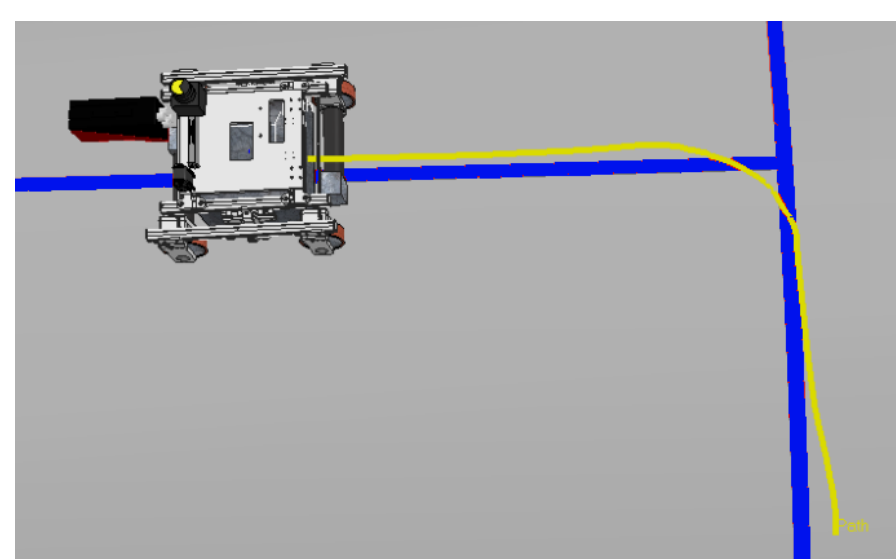
Figure 29. Path described by AIR1 during a curve.